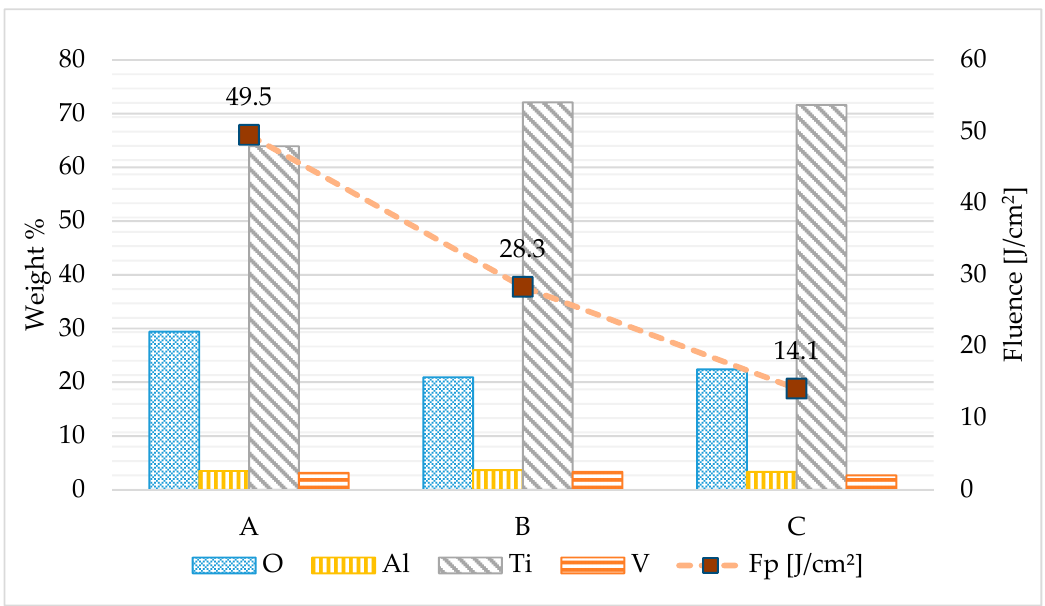
Figure 9. Weight % of individual elements according to fluence for laser structures A, B, C.